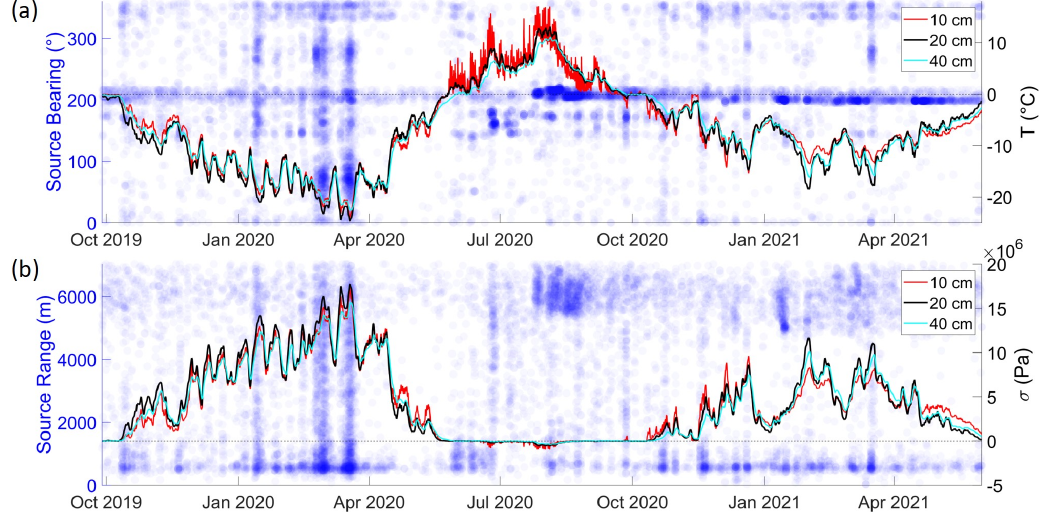
Figure 10. (a) Ground temperature profiles (solid lines) and bearing (clockwise from north) to coherent-MFP-localized source positions from the center of the SPITS array (blue circles). (b) Modeled ground thermal stress from Eq. (12) (solid lines) and ranges to coherent-MFP- localized sources (blue circles). Source ranges and azimuths are transparent such that denser colors represent clusters of